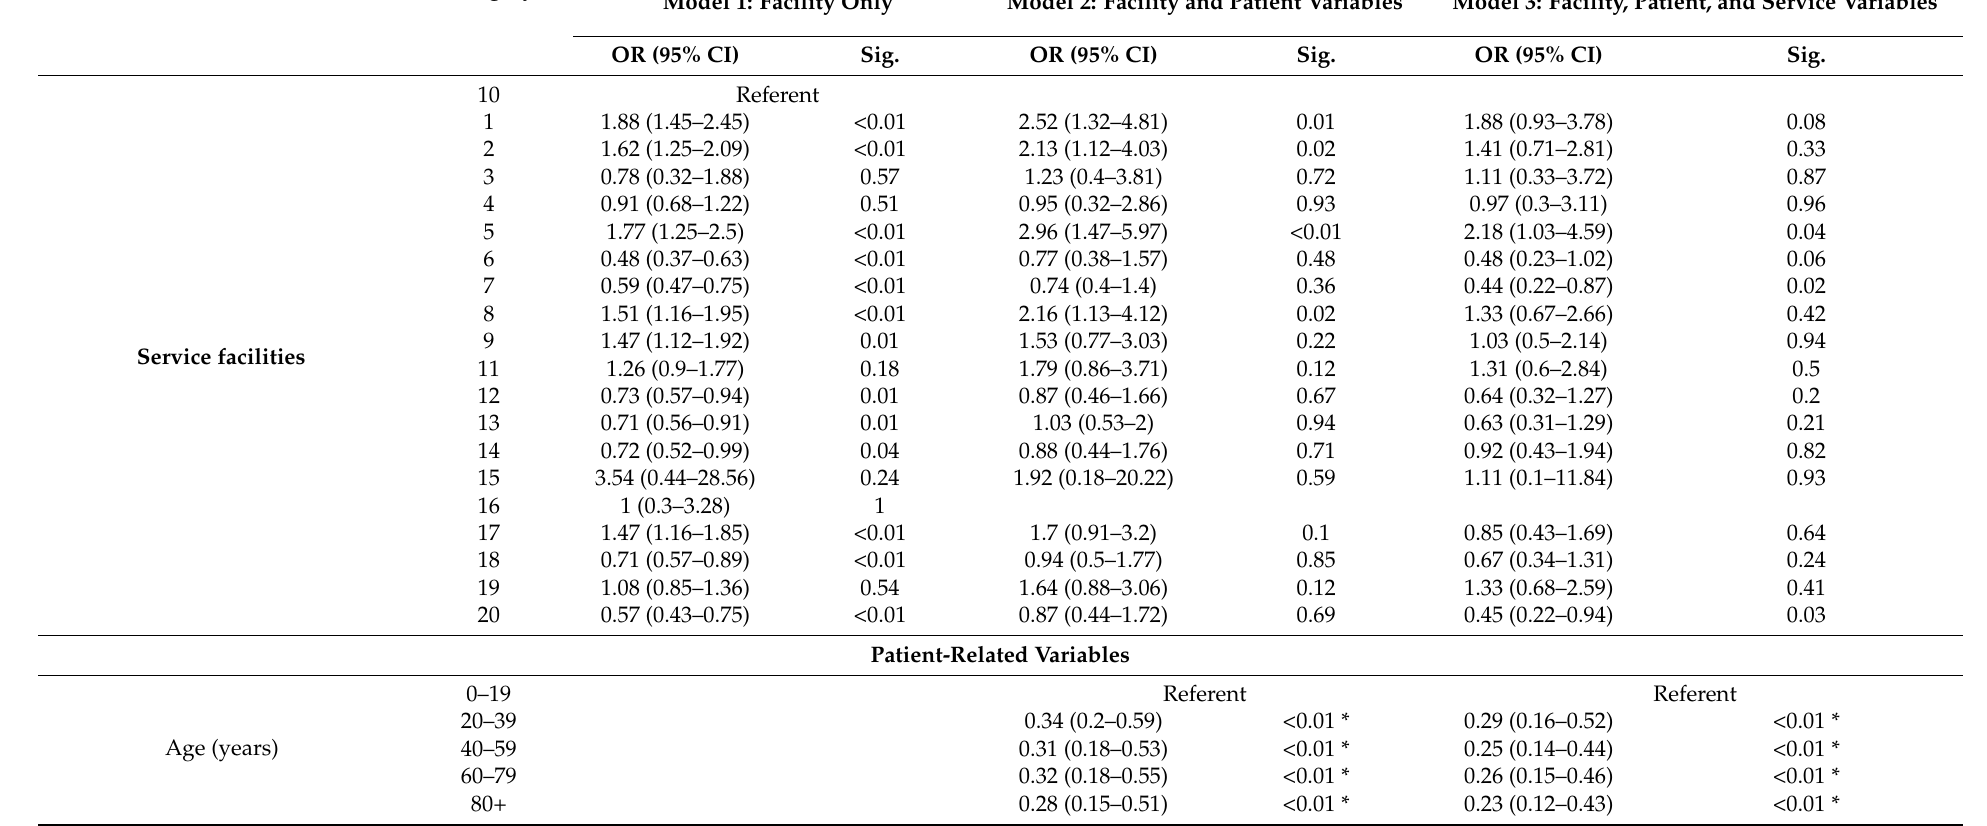
Table 5. Three hierarchical binomial regression models for the primary clinical outcome (Responder) evaluating the relationship between the clinical outcome and N/OPSC & MDS facility only (Model 1), adjusted for the patient-related variables (Model 2), and adjusted for service-related variables (Model 3). Significant service variables in the final model included management duration, triage category, nonattendance, and specialist input. Shaded cells represent sites with significant variance from the referent facility (Facility